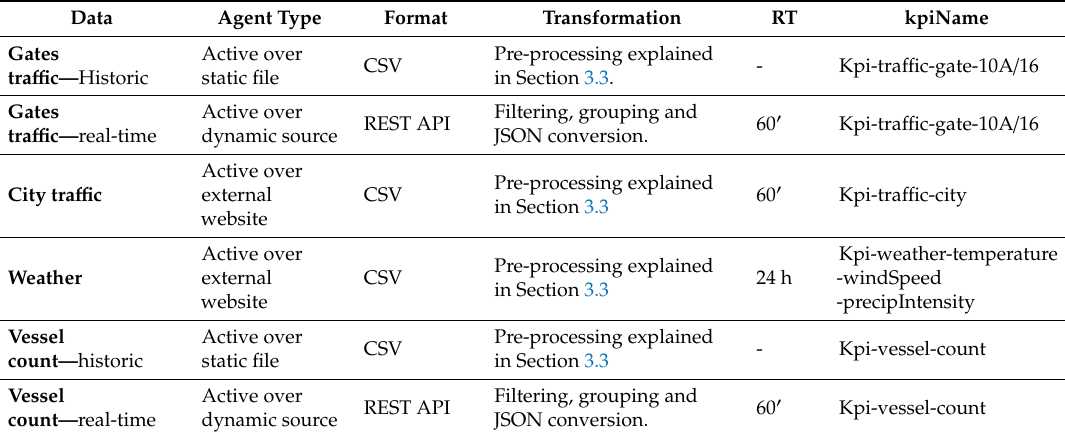
Table 4. Interoperability NGSI agents developed in the